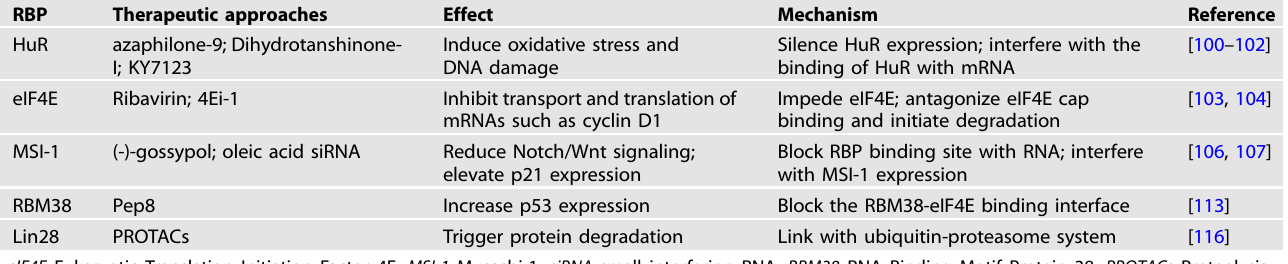
Table 3. The potential therapeutic approaches targeting RBPs in breast cancer treatment